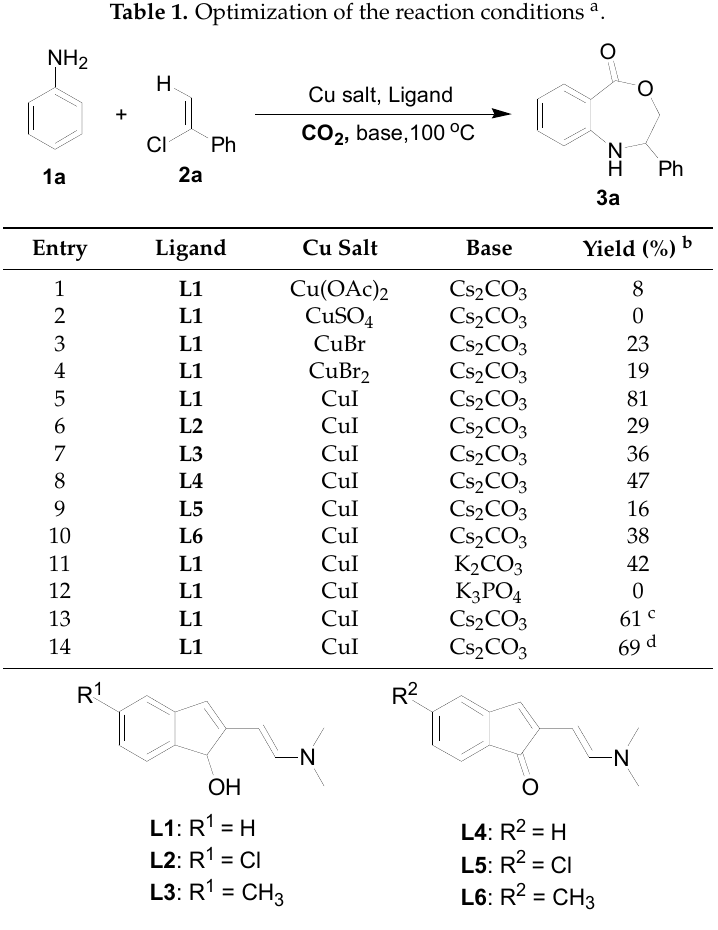
Table 1. Optimization of the reaction conditions a